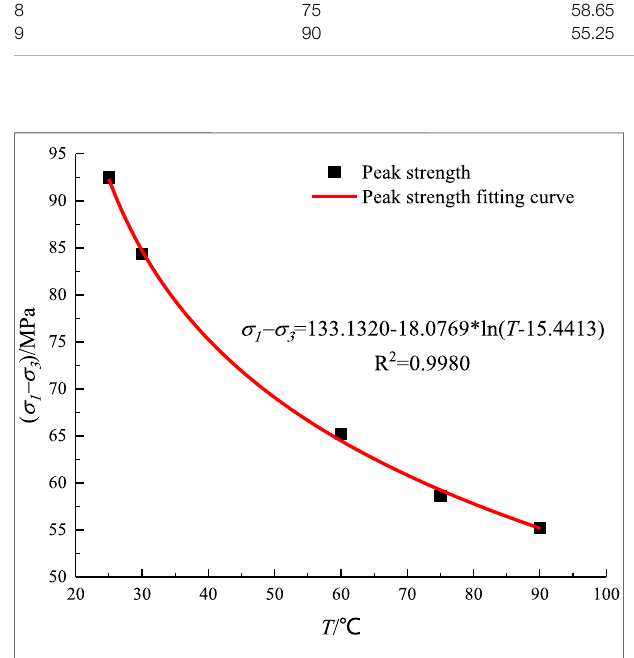
FIGURE 8 | The relationship between temperature and peak strength of sandstone under triaxial compression.